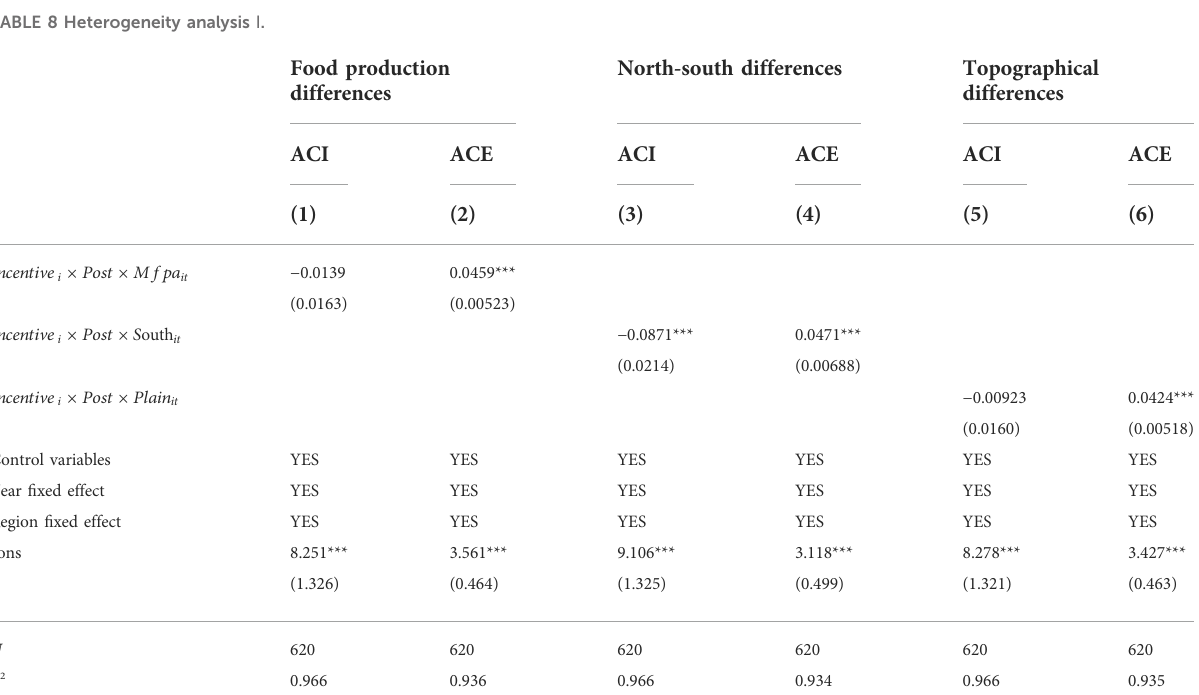
TABLE 8 Heterogeneity analysis Ⅰ